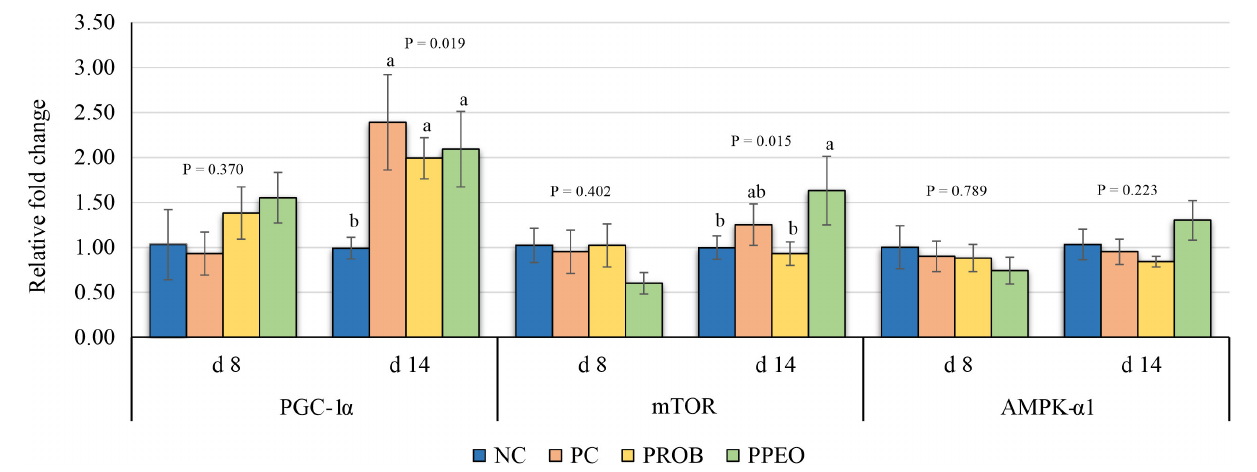
FIGURE 3 | Relative mRNA abundance of peroxisome proliferator-activated receptor-gamma coactivator (PGC)-1 α , mechanistic target of rapamycin (mTOR) and AMP activated protein kinase (AMPK)- α 1 in the jejunum of broiler chickens on day (d) 8 and 14. Birds reared under a naturally occurring necrotic enteritis challenge model. Treatments include: NC (negative control): corn-soybean meal basal diet; PC (positive control): NC + 20g virginiamycin (453g Stafac ® 20)/ton diet; PROB (Probiotic): NC + B. licheniformis spores at the level of 227 g/ton diet; PPEO (probiotic/prebiotic/essential oil supplement): NC + 453 g/ton of a supplement containing B. licheniformis spores, mannan-oligosaccharides, β -glucans (1,3 and 1,6), capsaicin, and curcuma. Values are represented as a n -fold difference relative to the calibrator (NC). Results are given as means ( n = 8) for each treatment. Error bars indicate standard errors. For each gene and sampling day, columns with different letters are significantly different ( P < 0.05).